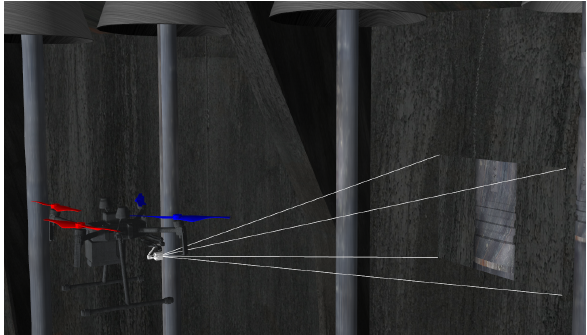
Figure 7. Matrice 200 v2 at Gazebo simulation.